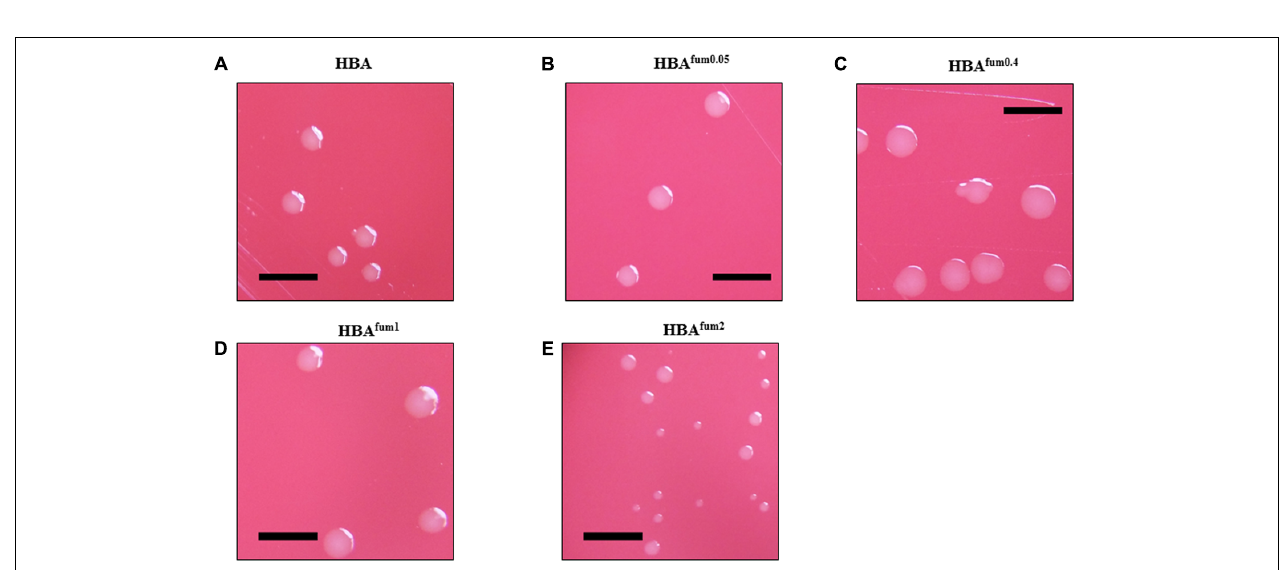
FIGURE 2 | Quantitative analysis of neutralized fumaric acid and neutralized monosodium fumarate on the growth of C. concisus . P26UCO-S1 and P2CDO4 are both C. concisus strains, the former isolated from a patient with UC and the latter from a patient with CD. Both strains were quantified after growth on HBA plates supplemented with varying concentrations of (A) neutralized fumaric acid and (B) neutralized monosodium fumarate. Fold changes were calculated relative to the CFU of the same strain cultured on plates without supplementation from the mean of quadruplicate counts on each media. ∗∗∗ indicates p < 0.001.